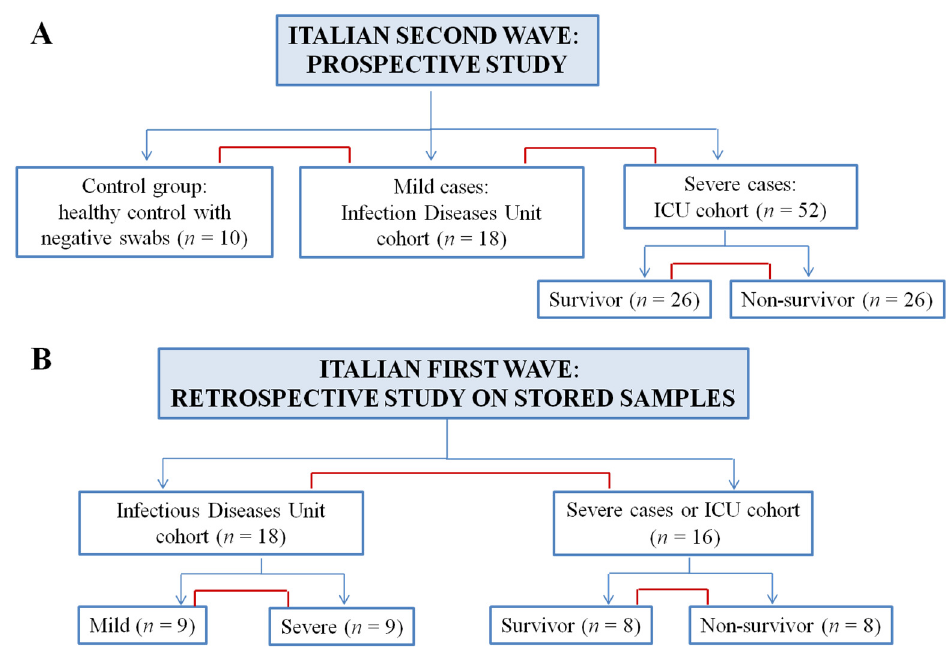
Figure 1. Flow diagram for patients’ enrollment and study design. ( A ) In the first phase of this study ten control subjects, eighteen patients from Infectious Diseases Unit and fifty-two ICU patients were enrolled in a prospective manner. Control vs. mild cases, mild cases vs. ICU patients, survivor vs non-survivor were compared. ( B ) Retrospective analysis of patients hospitalized during the first wave included eighteen patients from Infectious Diseases Unit stratified in nine mild patients and nine severe patients, and sixteen ICU patients stratified in eight survivors and eight non-survivors. First comparison was performed between mild and severe patients. Thus, Infectious Diseases Unit vs. ICU cohorts and survivor vs. non-survivor were